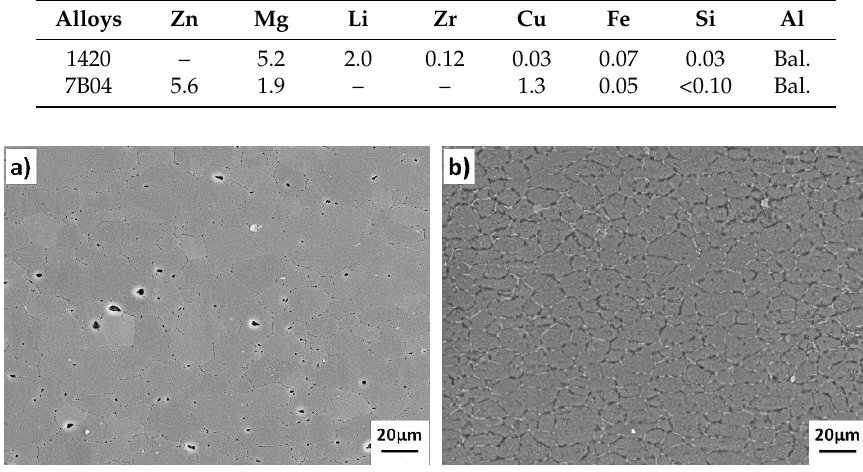
Figure 1. The original microstructure of the base materials: ( a ) 1420; ( b ) 7B04.